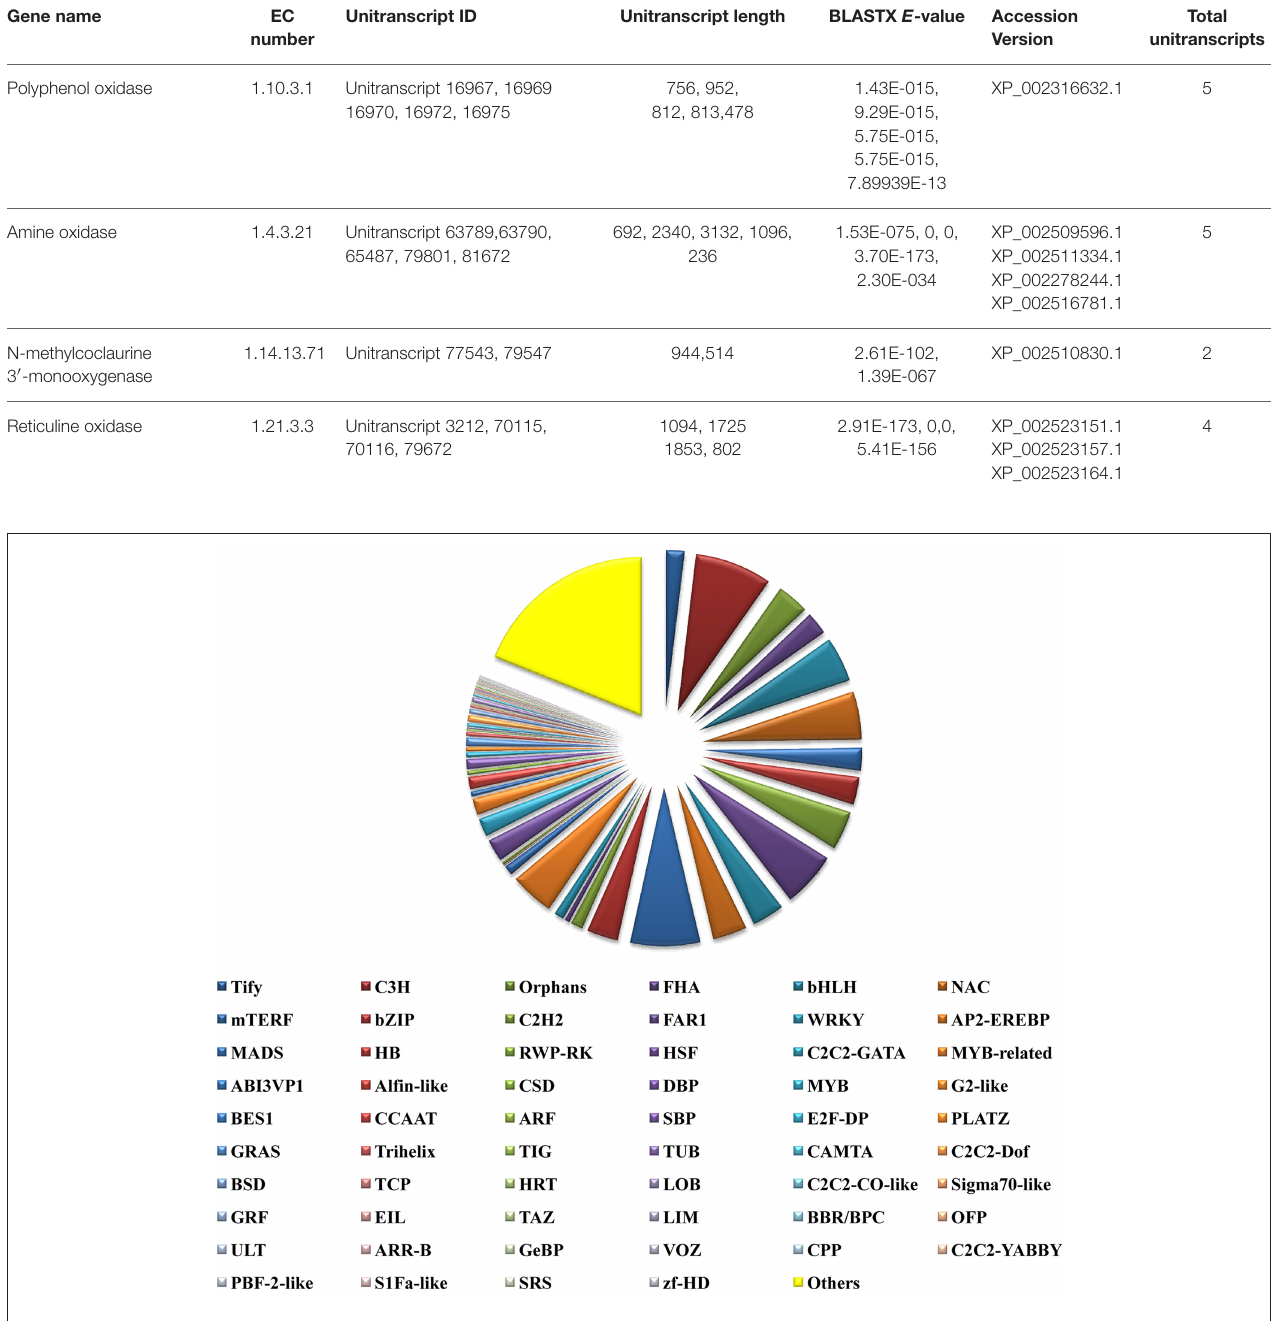
most abundant tetra-nucleotide repeat type occurring